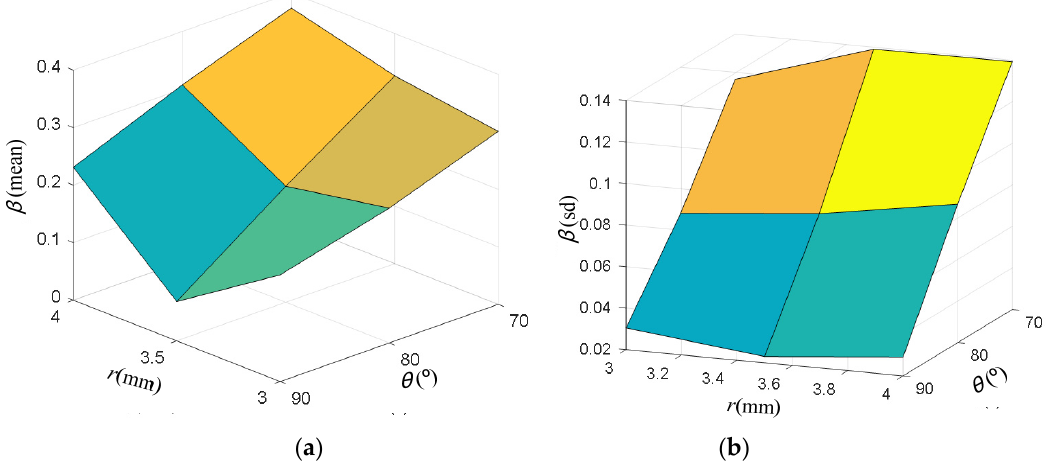
Figure 5. Error function β : ( a ) mean value; ( b ) standard deviation.